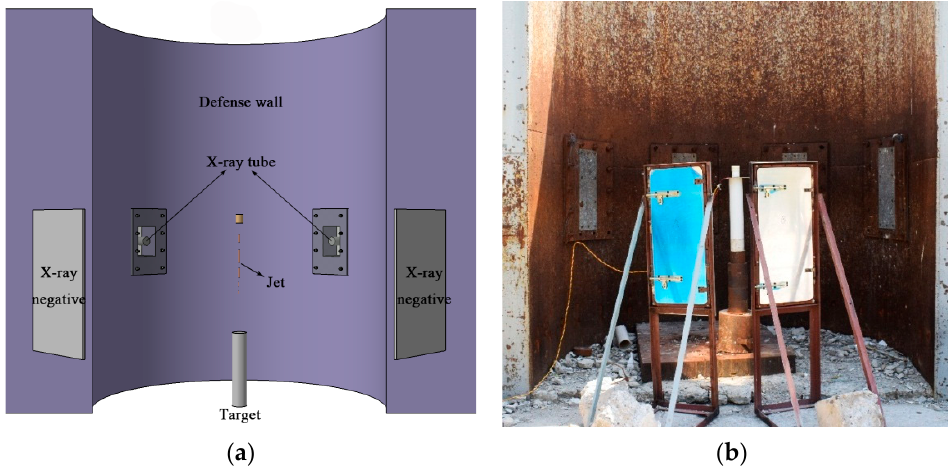
Figure 3. Pulsed X-ray experiment. ( a ) Schematic of the experimental layout; ( b ) Layout at the experimental site.